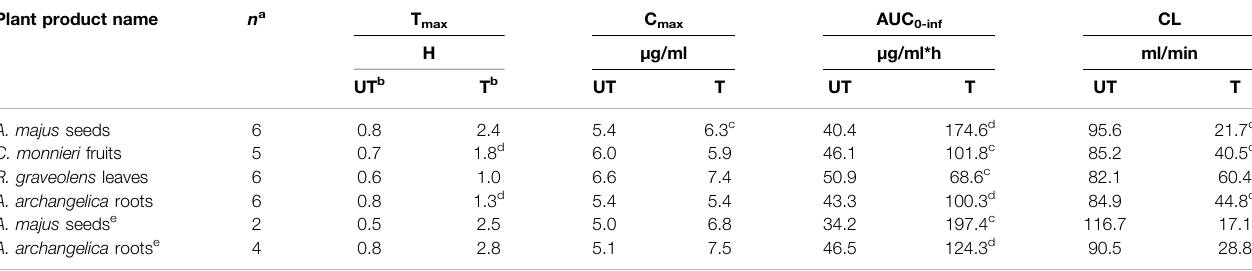
TABLE3| Caffeinepharmacokineticparametersinhumanvolunteersbeforeandafterpre-treatmentwiththeaqueousextractof A.majus,A.archangelica,C.monnieri, or R. graveolens . The ± SD of the data is omitted for better display and comparison. Plant product name